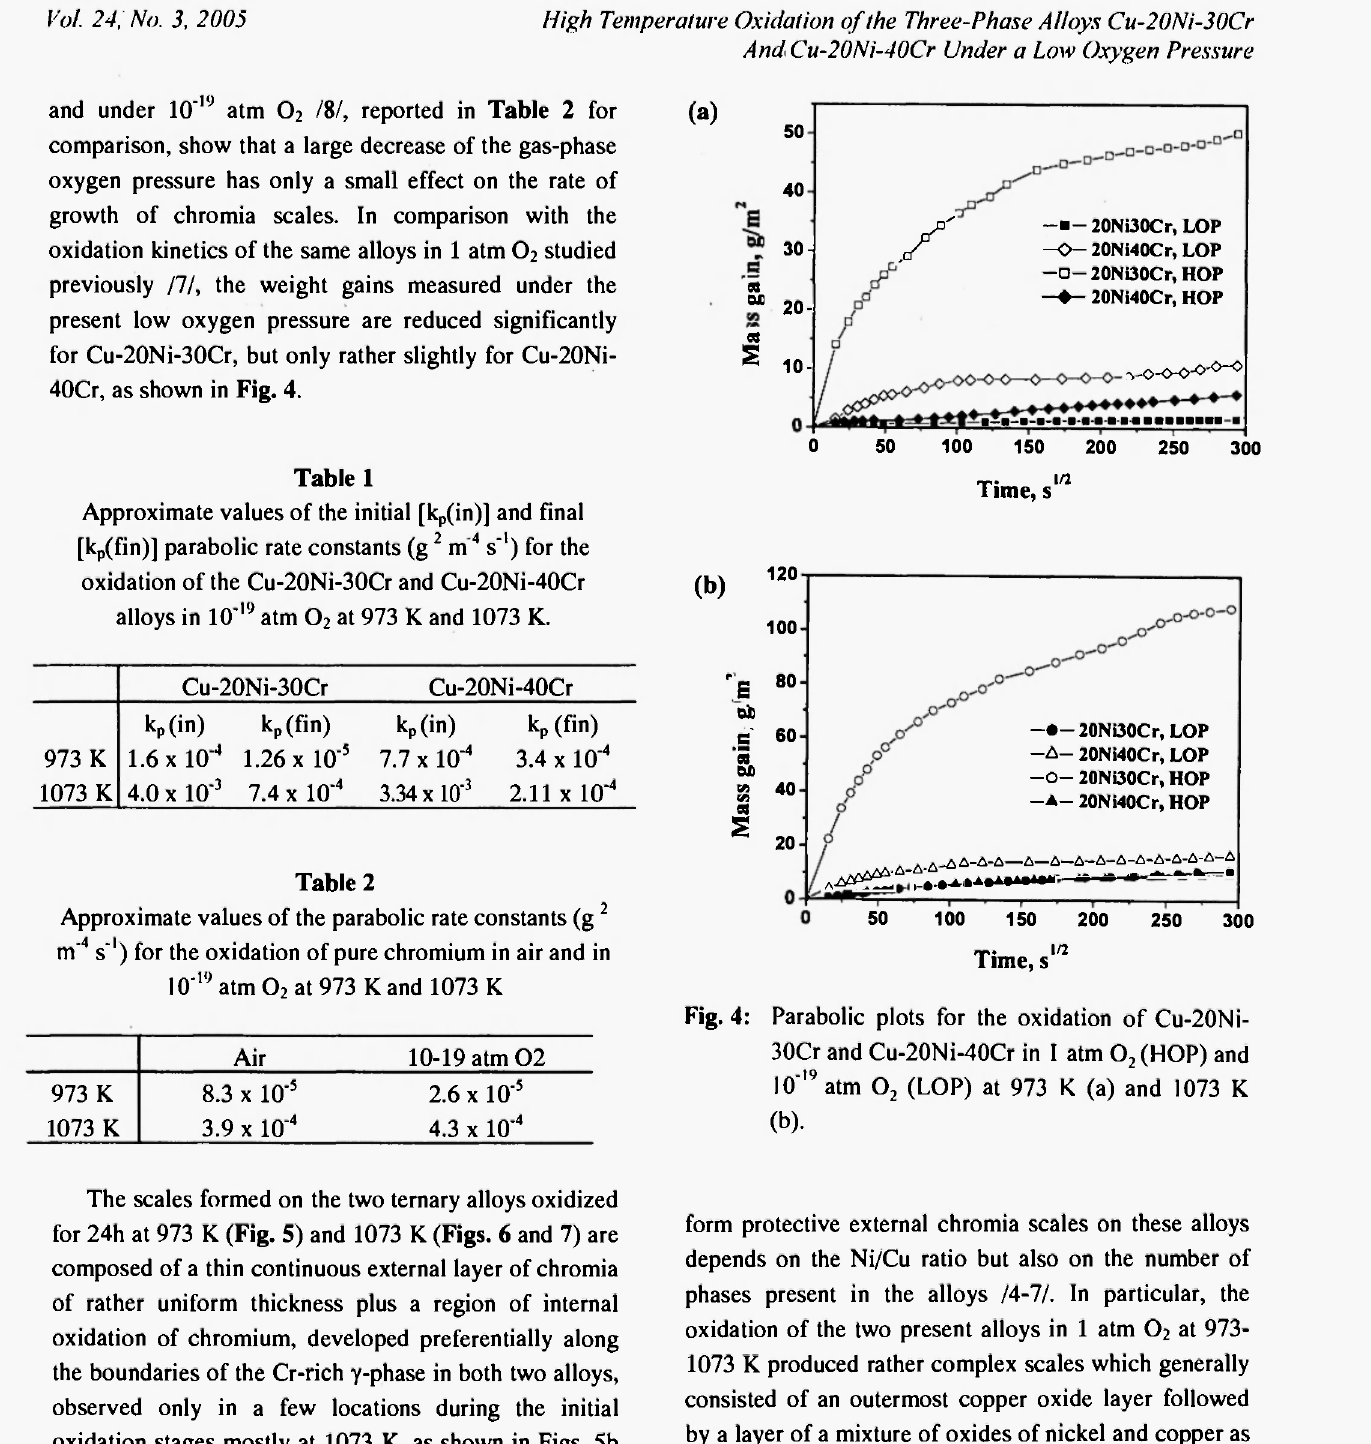
Fig. 4: Parabolic plots for the oxidation of Cu-20Ni- 30Cr and Cu-20Ni-40Cr in I atm 0 2 (HOP)